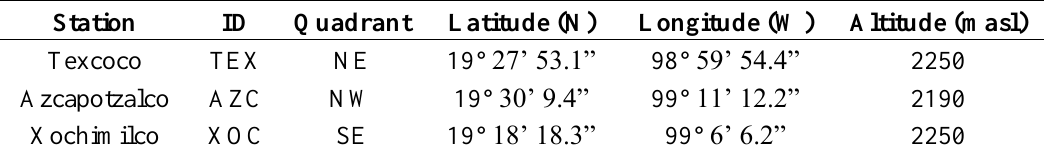
Table 8. Micrometeorological stations of the IIE2001